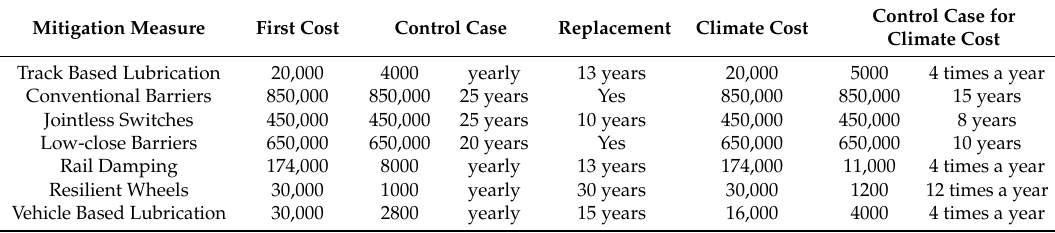
Table 3. Cost assumptions (in £) for life cycle analysis regarding squeal and impact noise abatement measures [25–30].